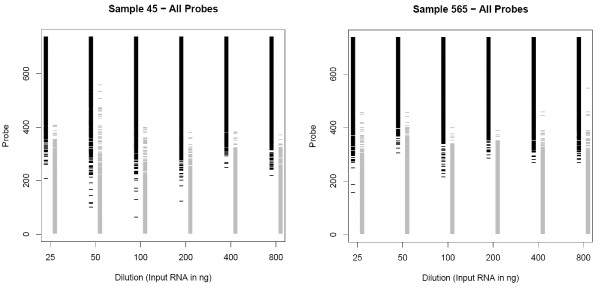
Probe signal detection. Detection coverage plots for both patients showing overlap in probe detection between dilutions. The two panels correspond to the two patients used for the dilution assessment. The horizontal axis corresponds to dilution, or amount of input RNA. For the vertical axis, the average intensity across the six dilutions was calculated for each patient separately. These average values were then ranked in abundance from 1 (lowest average abundance) to 735 (highest average abundance). The vertical axis corresponds to this ranking. The left column for each dilution corresponds to probes detected; and a black horizontal line is drawn only if a probe is detected in that dilution; white space if a probe is not detected. Due to the density of the probes in the column, a second column is included for each dilution indicating negative detection calls; a gray horizontal line is drawn if the probe is not detected; white space if a probe is detected. Thus, a probe detected (or not detected) in all dilutions would have a black (or gray) line in all dilutions.